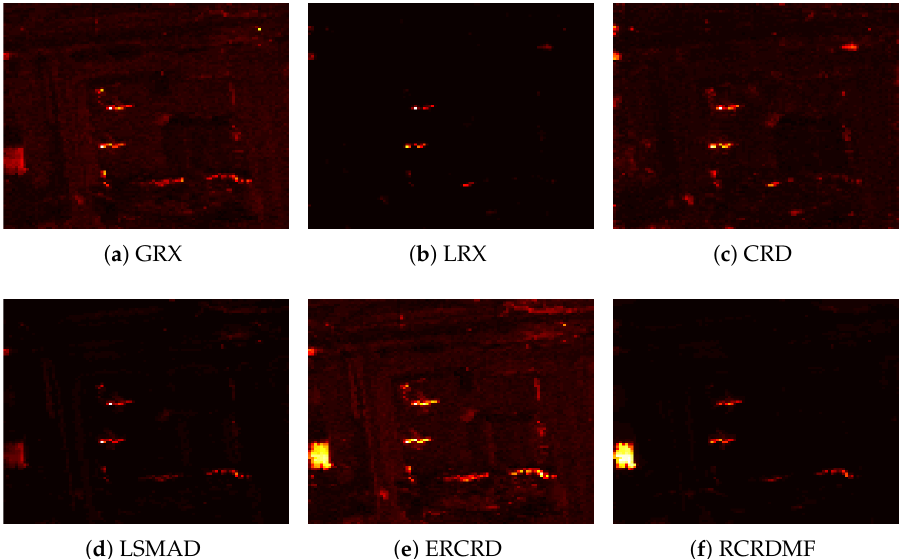
Figure 13. Color detection maps obtained by different algorithms for the abu-airport-2 dataset. ( a )